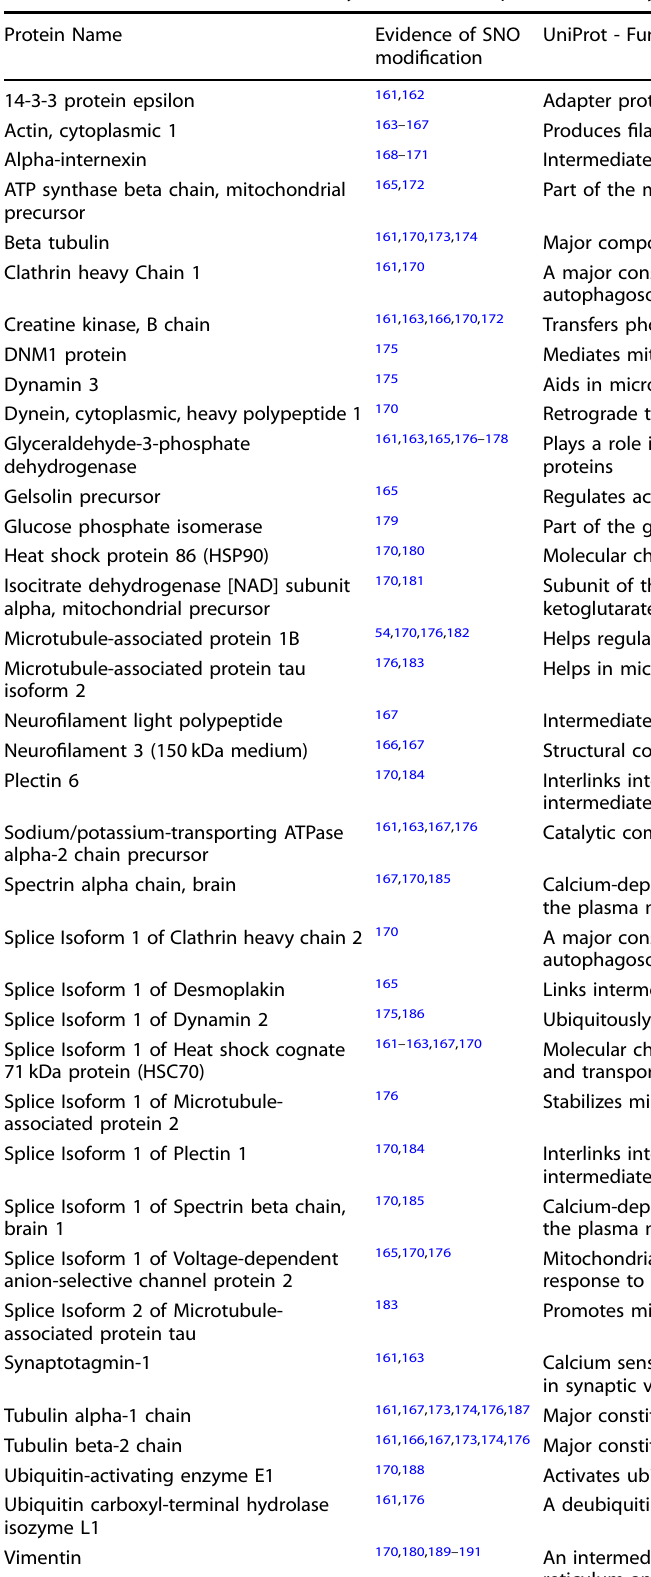
Table 1. Identi fi ed constituents of Lewy Bodies that are prone to